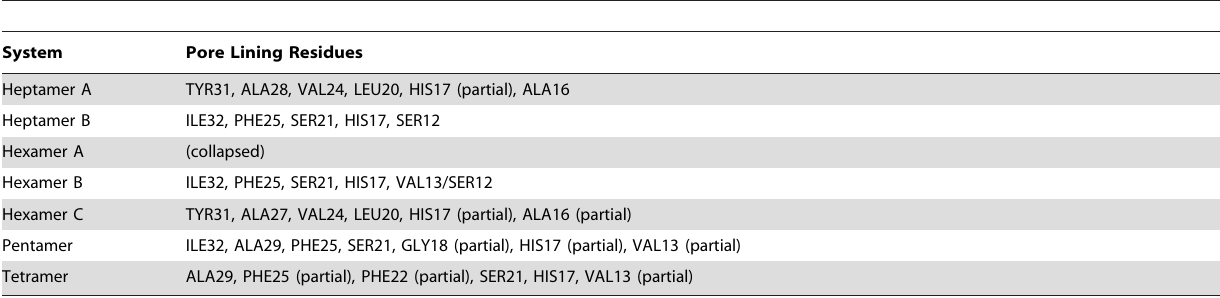
Table 2. List of pore-lining residues for each p7 oligomer